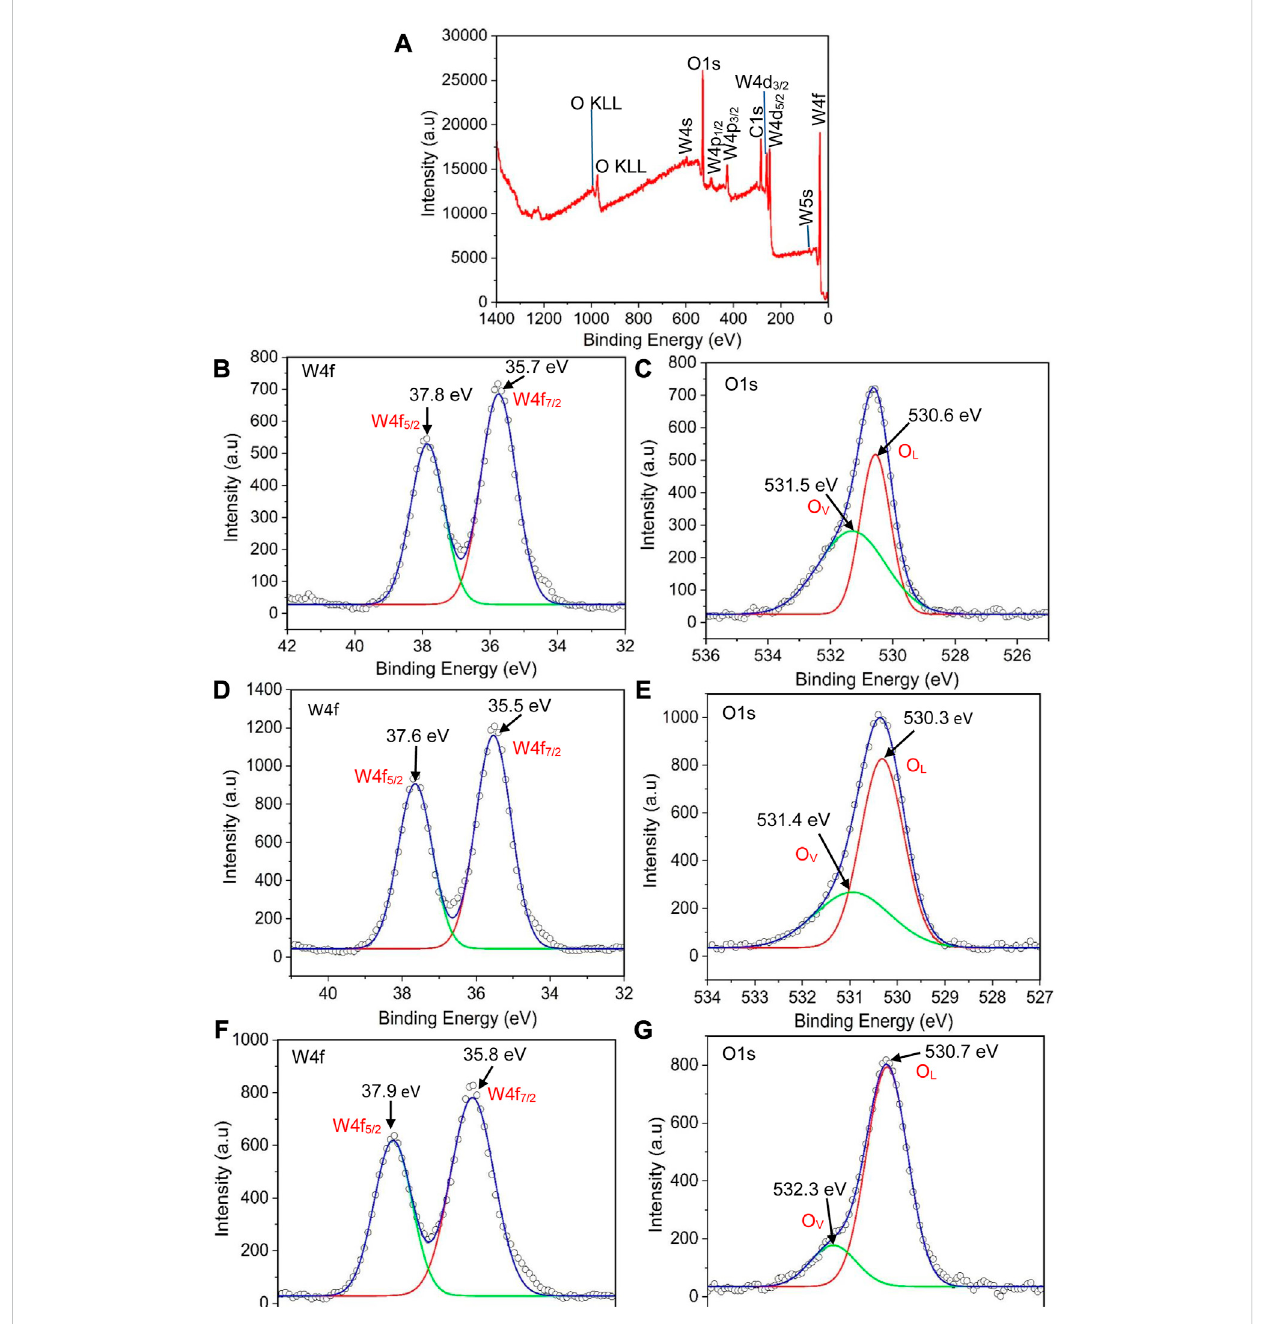
FIGURE 8 (A) XPSsurveyspectrumofWO 3 -HClsample, (B,C) theW4fandO1sspectraofWO 3 -HNO 3, (D,E) ,theW4fandO1sspectraofWO 3 -H 2 SO 4 ,and (F, G) the W 4f and O1s spectra of WO 3 - H 2 SO 4 .